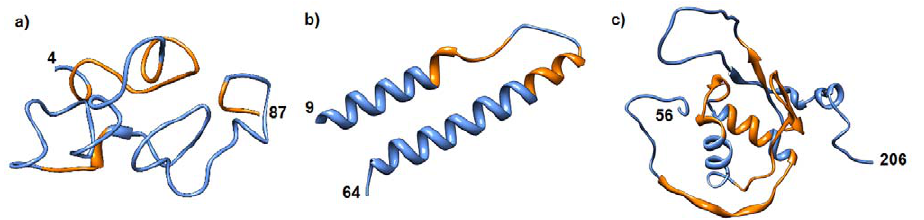
Figure 4. Hotspots on HIV protein structures. Hotspot regions highlighted in orange on Tat (a), Rev (b), and Nef (c) proteins. PDB structures 1TBC [41], 2X7L [42], and 2NEF [43] were used respectively. Numbers on the structures reflect the start and stop positions on the actual HIV protein sequence. Molecular graphics images were produced using the UCSF Chimera package [44]. doi:10.1371/journal.pone.0023293.g004 PLoS ONE |